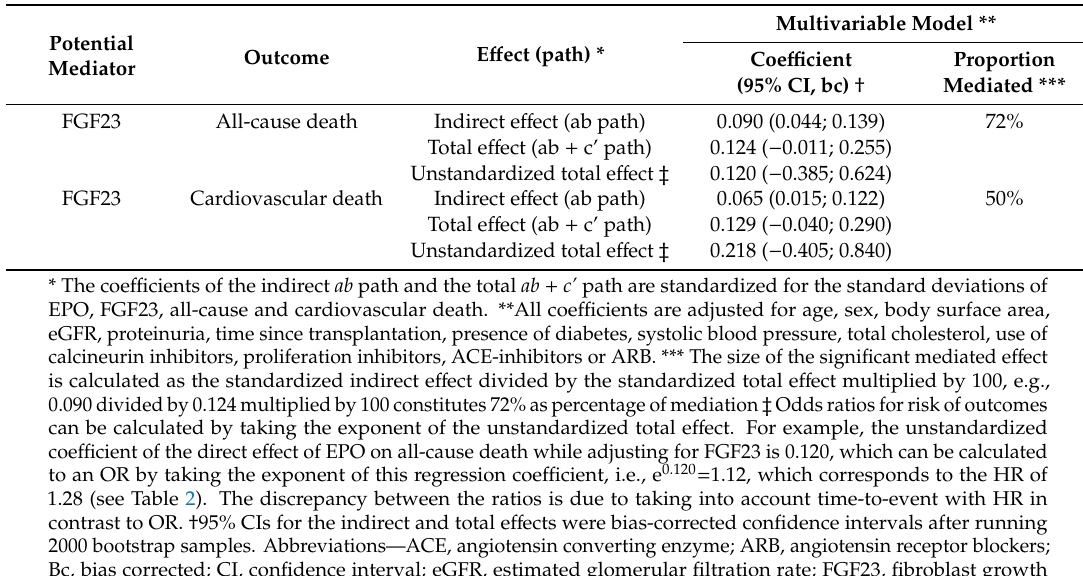
Table 4. Mediation analysis of FGF23 on the association between EPO and all-cause and cardiovascular death in renal transplant